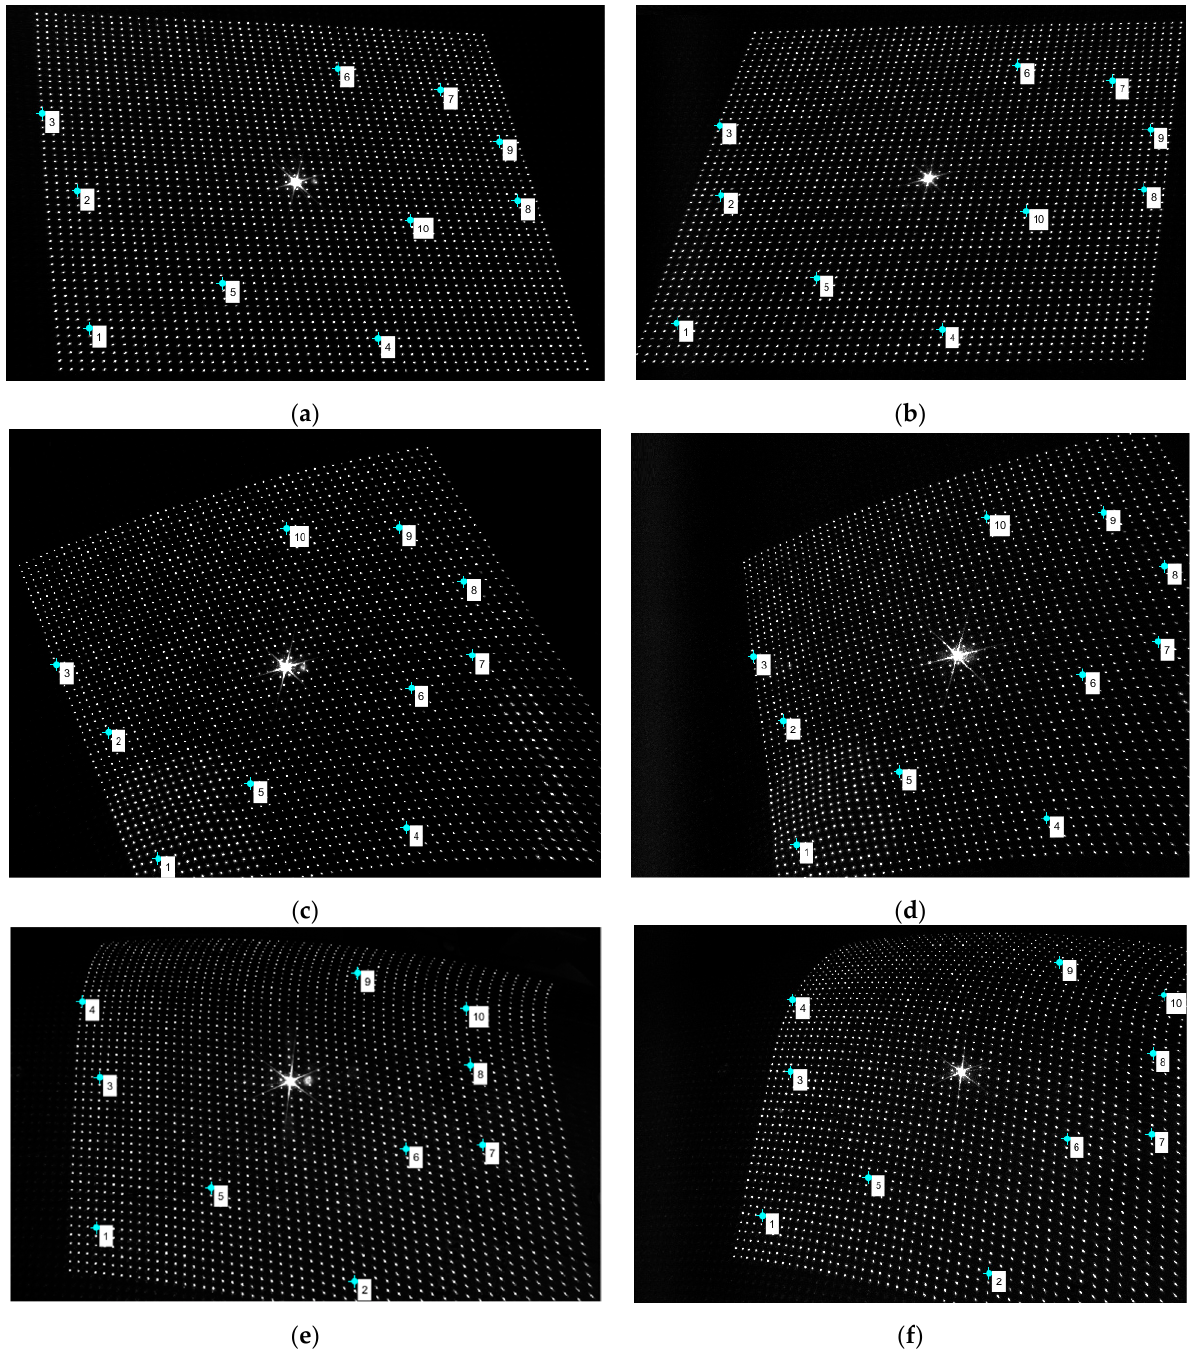
Figure 13. The arrangement of the matching points (variant W1) rotated to the right: ( a , b ) Images of the marker grid with small deformation; ( c , d ) images of the marker grid characterizing medium deformation; ( e , f ) images of the marker grid characterized by large deformation. Left column— images from the left camera, right column—images from the right camera.